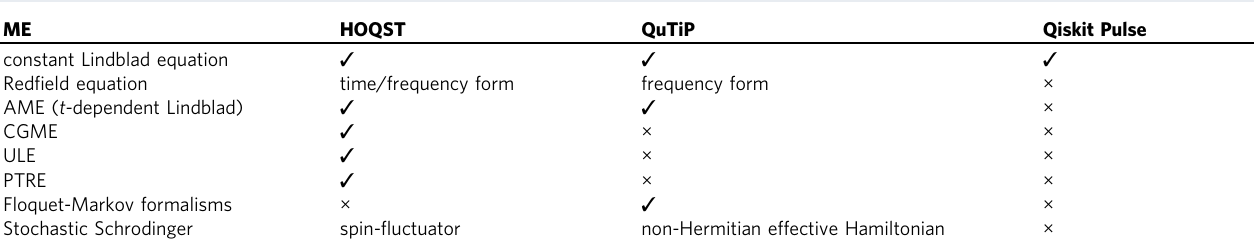
Table 2 Comparison chart for master equation (ME) support. The table lists the supported ME types for HOQST, QuTiP and Qiskit Pulse.